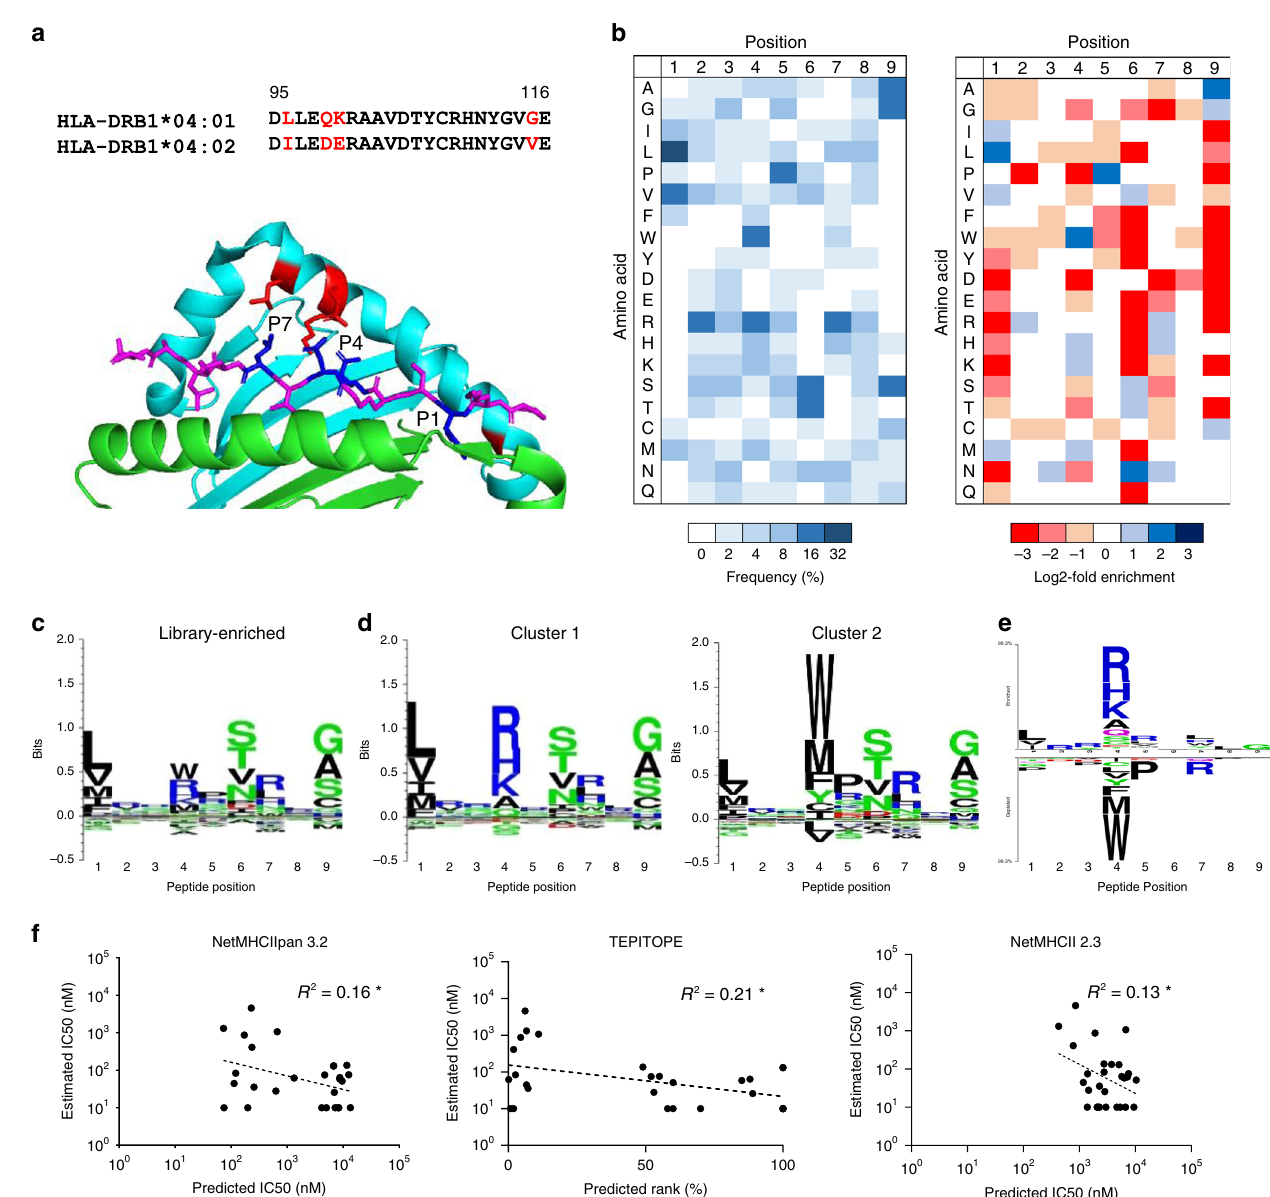
Fig. 5 Selection, analysis, and validation of a HLA-DR402 library. a Structure of HLA-DR401 complexed with HA 306-308 (PDB 1J8H) highlighting HLA- DR402 polymorphisms (red) and polymorphism-proximal peptide positions (blue), with associated sequence alignment. b Unweighted heat maps of positional percent frequency and log2-fold enrichment of each amino acid in round 5 of selection of a randomized 9mer HLA-DR402 library ( n = 7,692 unique peptides). c , d Kullback – Leibler relative entropy motifs of the core nine amino acids of HLA-DR402-binding peptides, either determined empirically from our yeast-display library, or in each of the two clusters found within our library. e Amino acids signi fi cantly ( p < 0.05) more represented at each position within the core 9 amino acids of HLA-DR402-binding peptides between clusters. Displayed size of residues correlates with statistical signi fi cance of deviation and signi fi cance was determined by two-sided unweighted binomial test for p < 0.05, with a Bonferroni correction for multiple hypothesis testing. f Scatterplots of algorithmic predictions versus measured IC 50 with lines of best fi t and their associated coef fi cients of determination ( R 2 ). Asterisk denotes R 2 values of negative correlations. Source data are provided as a Source Data fi